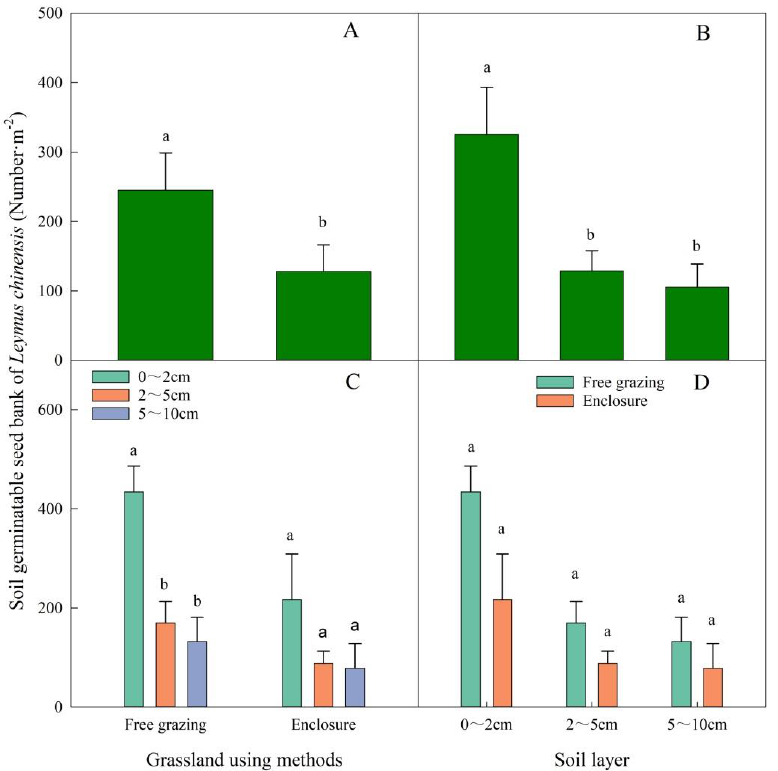
Figure 2. Effects of grassland use and soil layer on the soil germinable Leymus chinensis seed bank. Note: Lowercase letters represent significant differences between different using methods or different soil layers ( p < 0.05). Subfigure ( A ) shows total soil germinatable seed bank of L. chinensis at 0–10 cm under different using methods. Subfigure ( B ) shows total soil germinatable seed bank of L. chinensis of free grazing and enclosure at different soil layers. Subfigures ( C , D) show soil germinatable seed bank of L. chinensis under different using methods and soil layers.